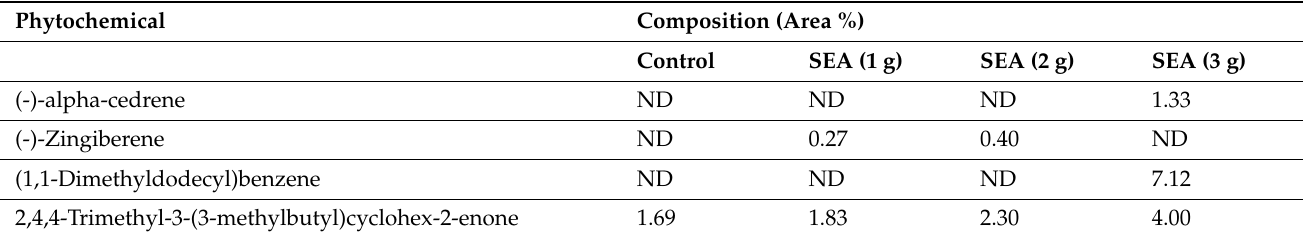
Table 9. Components identified by GC-MS analysis in the C. longa ethanolic rhizome extracts from different Spirulina platensis aqueous extract (SAE) treatments. Each area (%) was calculated from the measurements obtained from the ethanolic extracts of 3 plantlets. ND means non